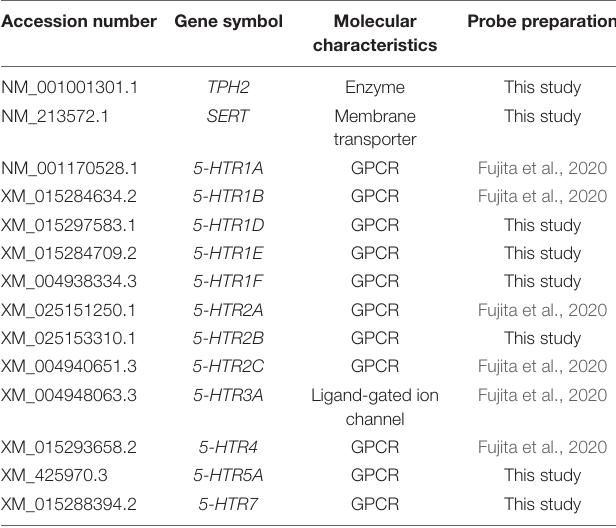
TABLE 2 | Overview of the serotonergic neuron marker and 5-HTR s probes used in this study. Accession number Gene